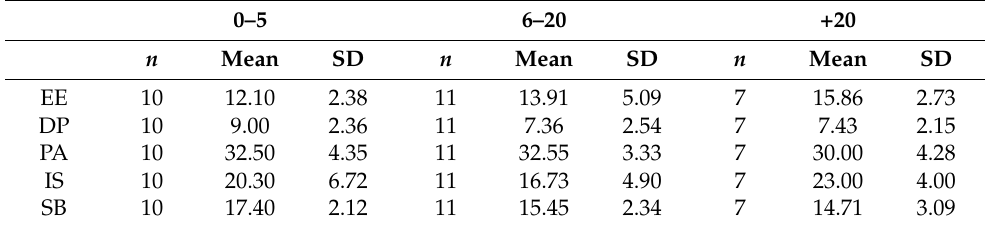
Table 7. Results of the dimensions by tutorial